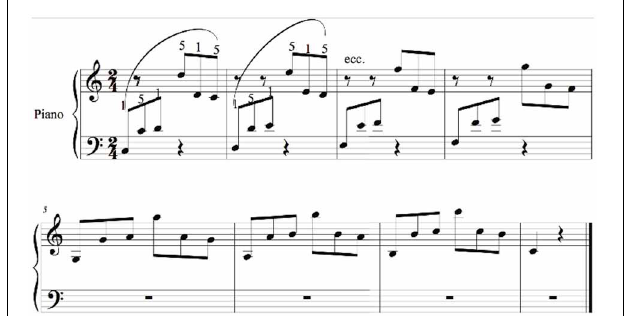
FIGURE 2 | Experimental paradigm. MP, Mental practice; PP, Physical practice; SMQ, Seven-minute questionnaire aimed at describing the mental strategies used during